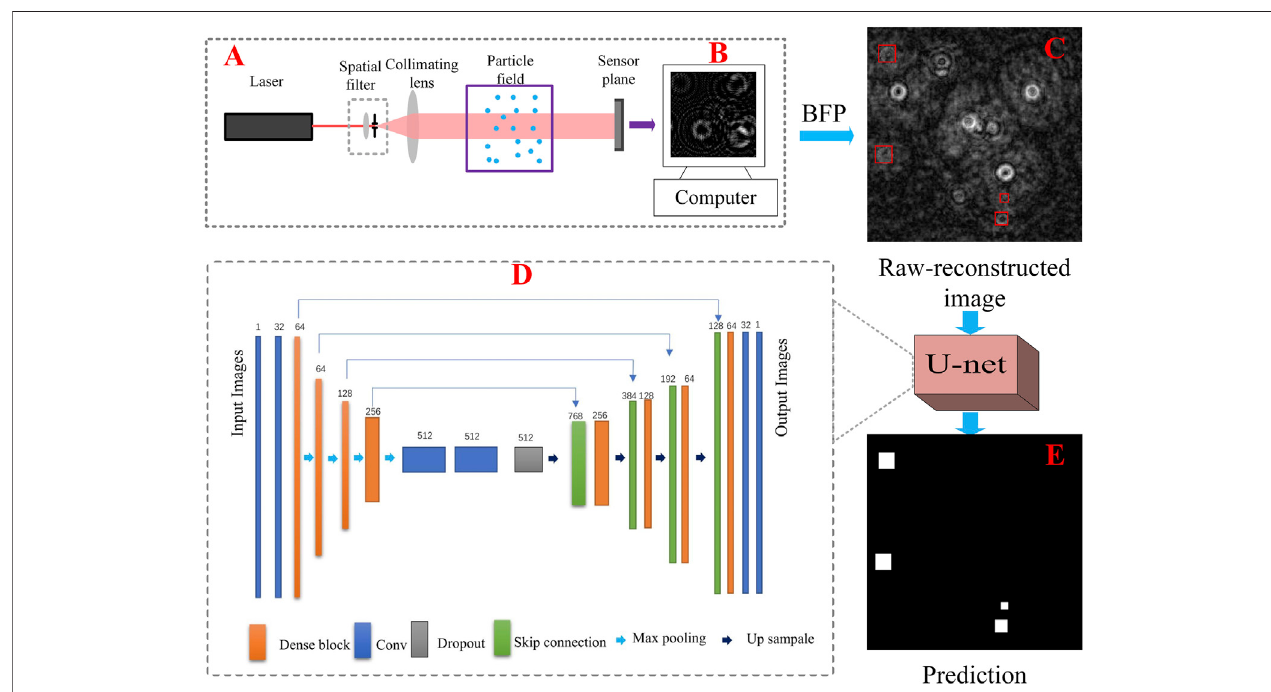
FIGURE 1 | (A) In-line digital holographic experimental setup; (B) pre-processed hologram; (C) raw-reconstructed image at 5,238 μ m; (D) the proposed U-net model; (E) the predicted image of the U-net model corresponding to (C) .